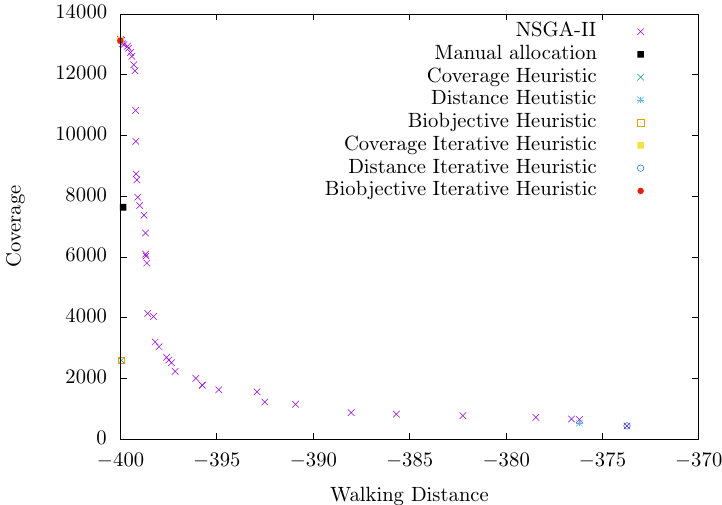
Figure 12. NSGA-II approximated Pareto front and solutions of heuristic algorithms in MU1 instance compared to the manual allocation (72 stations).